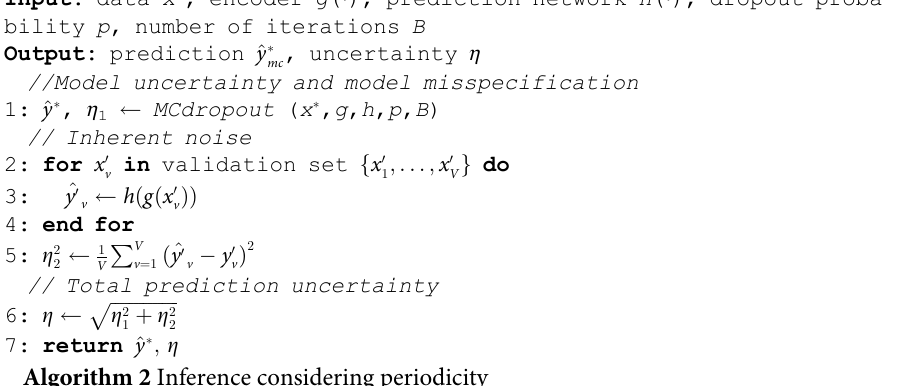
Algorithm 1 Inference (from [9])